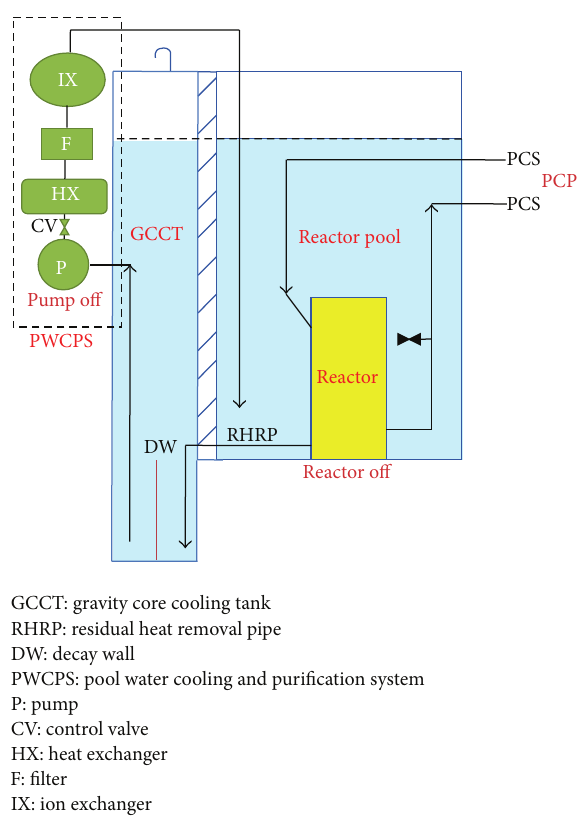
Figure 5: Schematic diagram of PRHRS using GCCT.